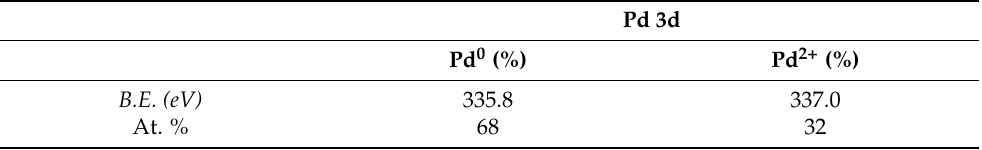
Figure 2. TEM analysis with relative mean diameter (Dm) and standard deviation (SD) of 1% Pd/GNP. Table 2. XPS analysis of the Pd 3d orbital with Pd 0 and Pd 2+ relative abundance of 1% Pd/GNP.